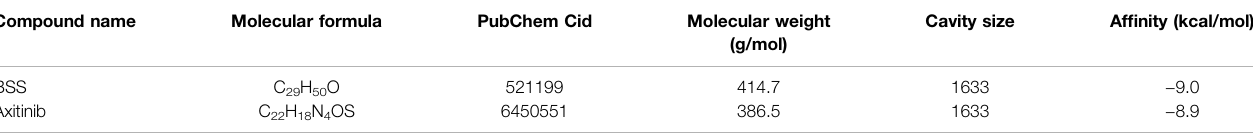
TABLE 1 | Binding af fi nity between VEGFR2 and BSS.